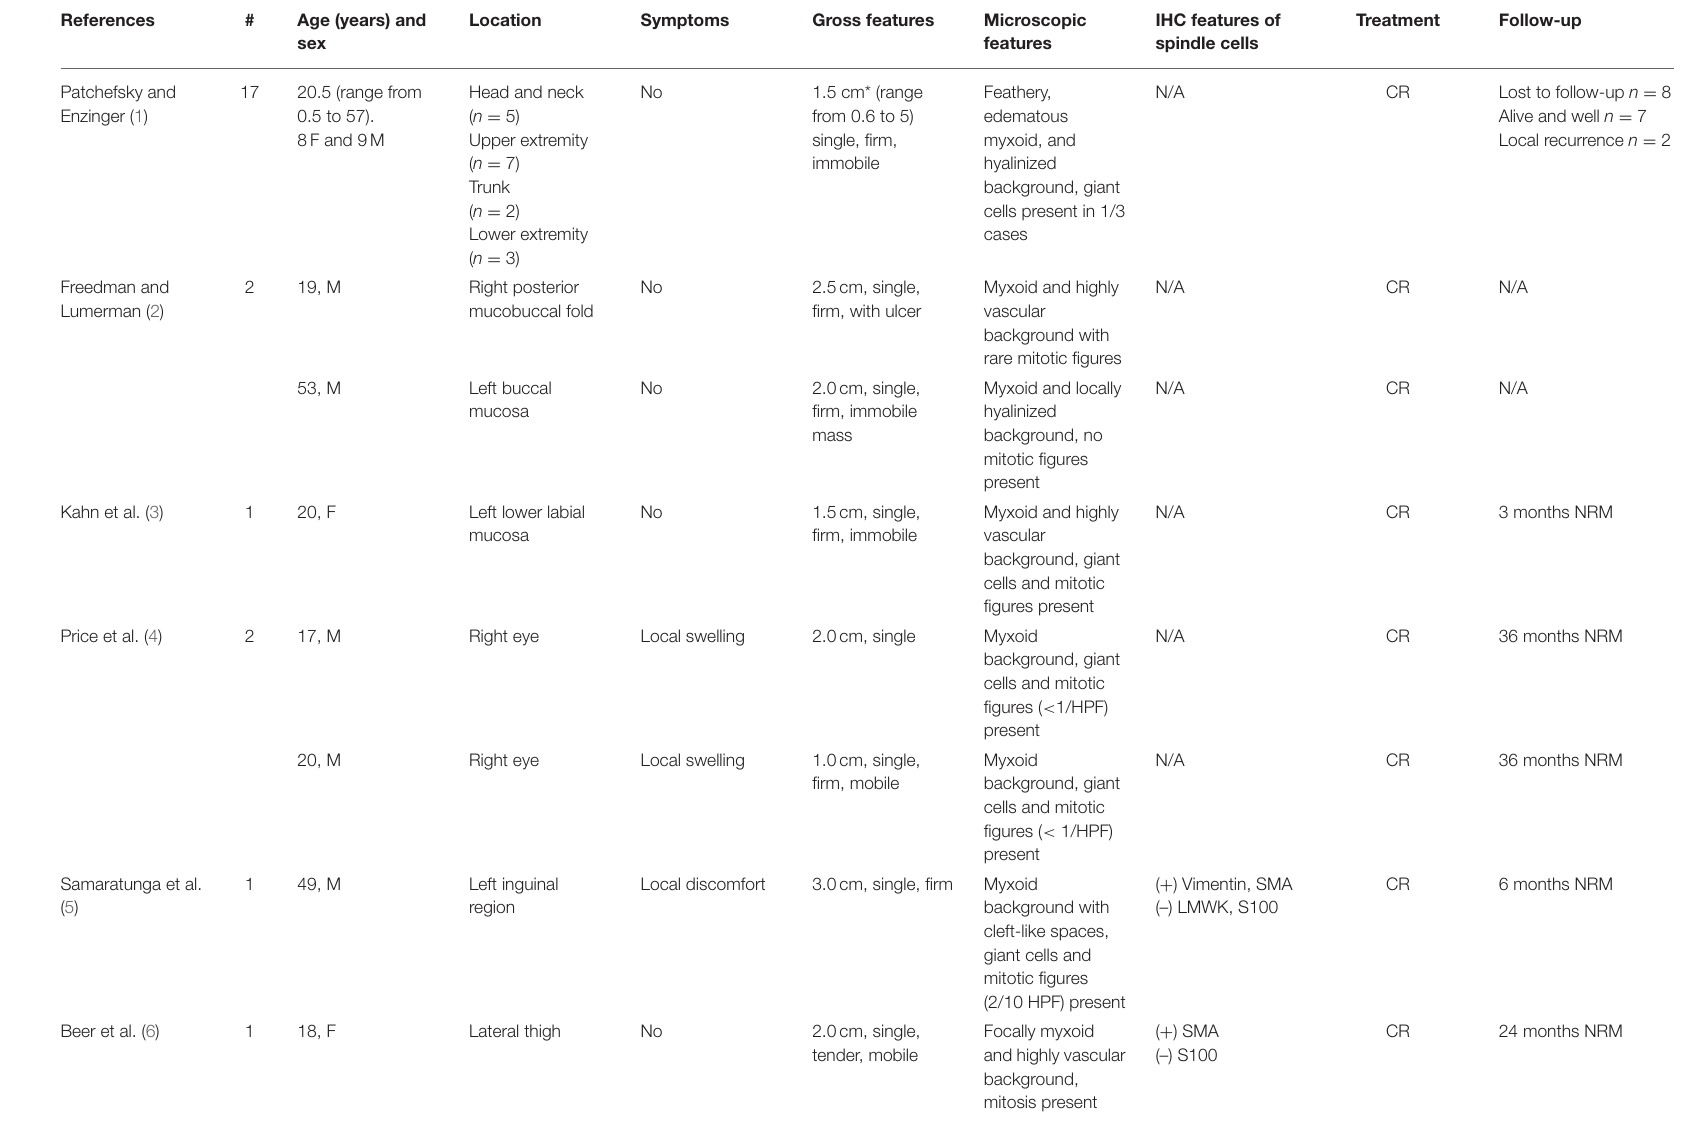
TABLE 1 | Clinical and pathologic features of the reported cases of intravascular